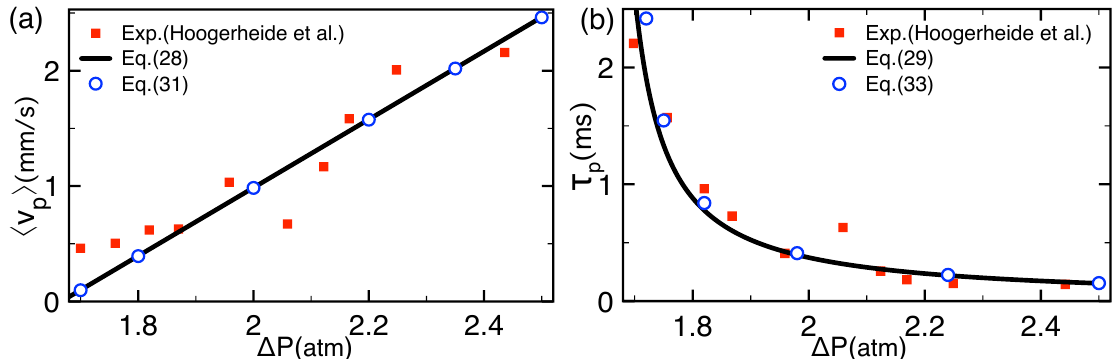
(cid:10) (cid:11) v p obtained from